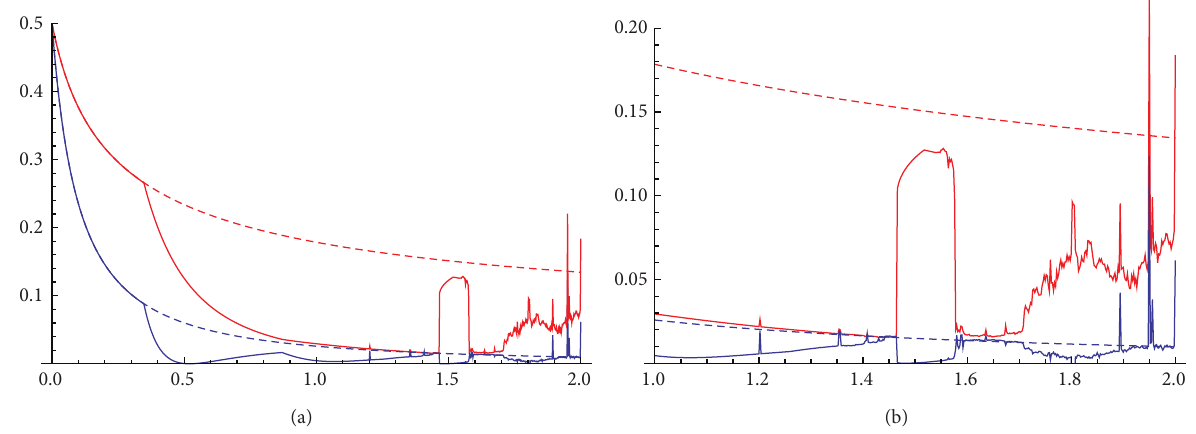
Figure 21: For 𝛼 = 1.3 and 𝛽 ∈ (1, 2] , we show the average profits of firms 1 (blue) and 2 (red) with initial conditions 𝑥 0 = (1/𝛽)(1−√1 − 1/𝛼) , = 0.999 . We also show the profit at the Cournot points for firms 1 (dashed and blue) and 2 (dashed and red). The first figure (a) shows in 𝑦 0 the 𝑋 axis the parameter 𝛽 ∈ [0,2] , and the second one (b) with 𝛽 ∈ [1, 2] is a zoom of the first one.